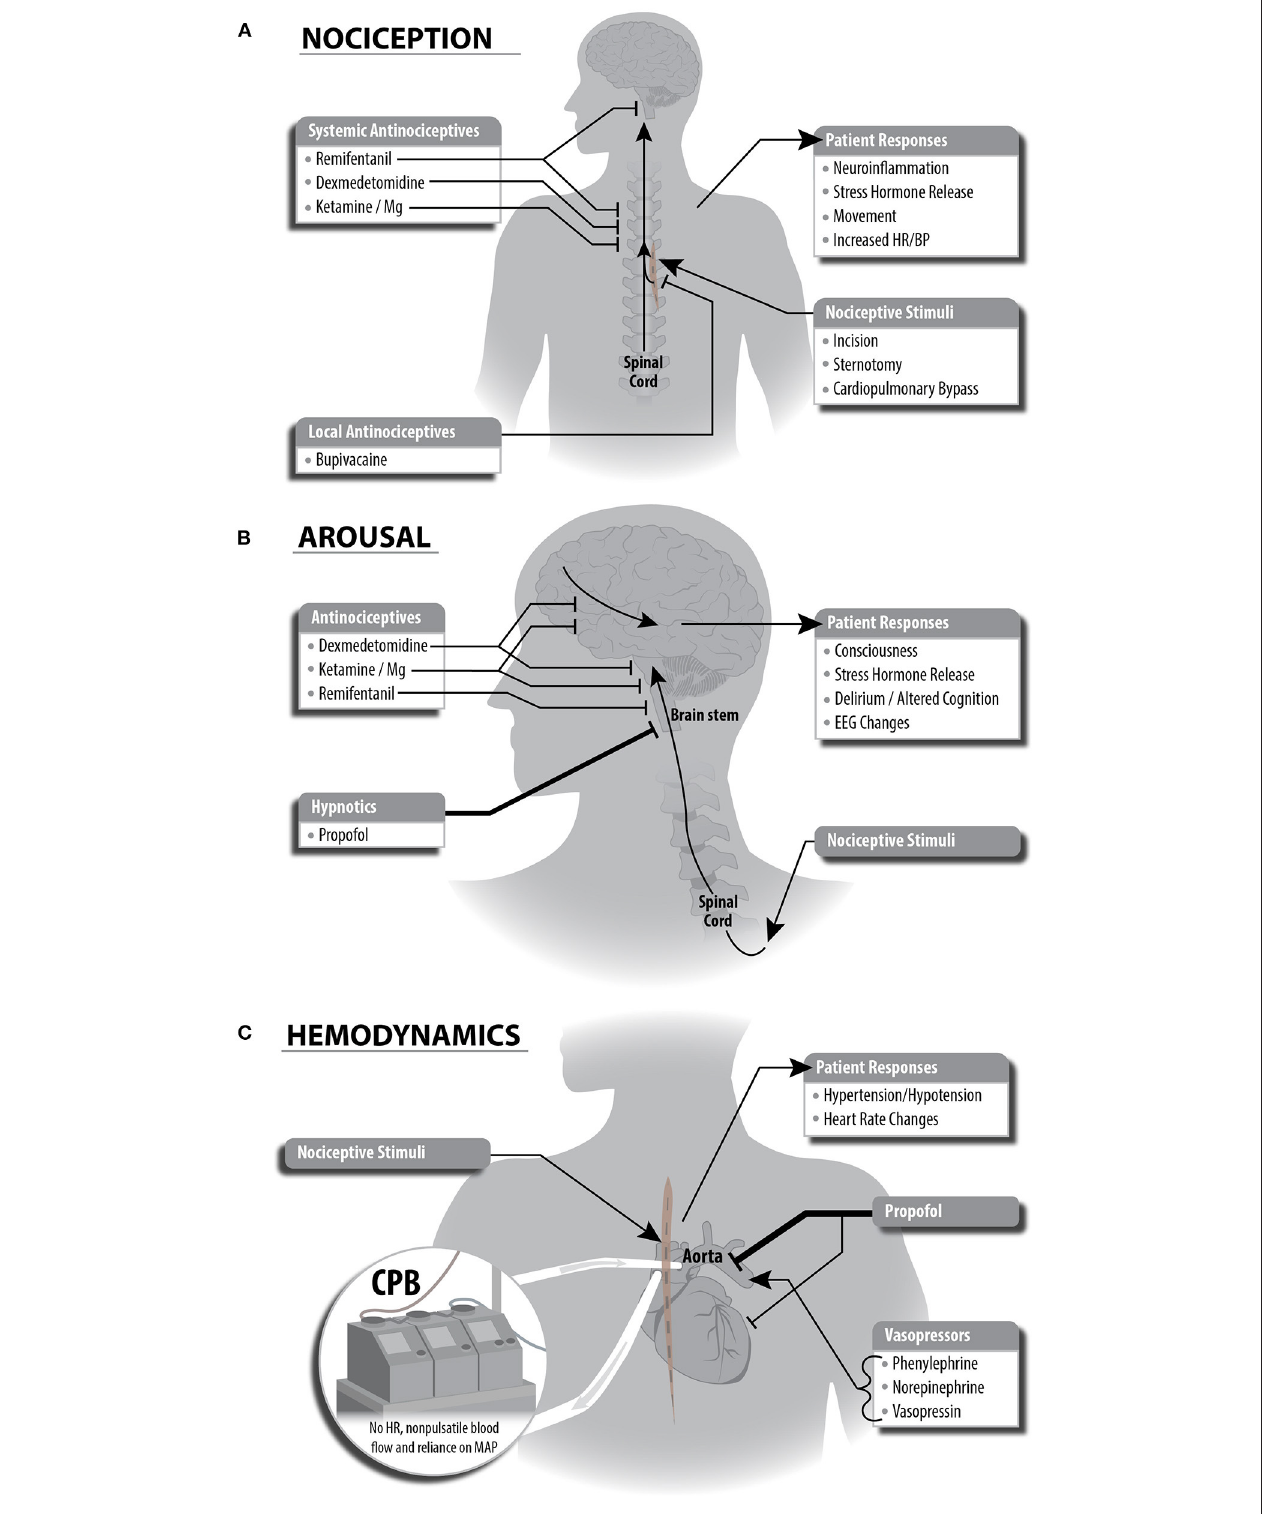
FIGURE 1 | Schematic depictions of multimodal general anesthesia protocol split into individual components for anesthetic plan. (A) Nociceptive stimuli are managed with local and systemic anitinociceptives. This strategy leverages complementary mechanisms of each antinociceptive drug to achieve inhibition of